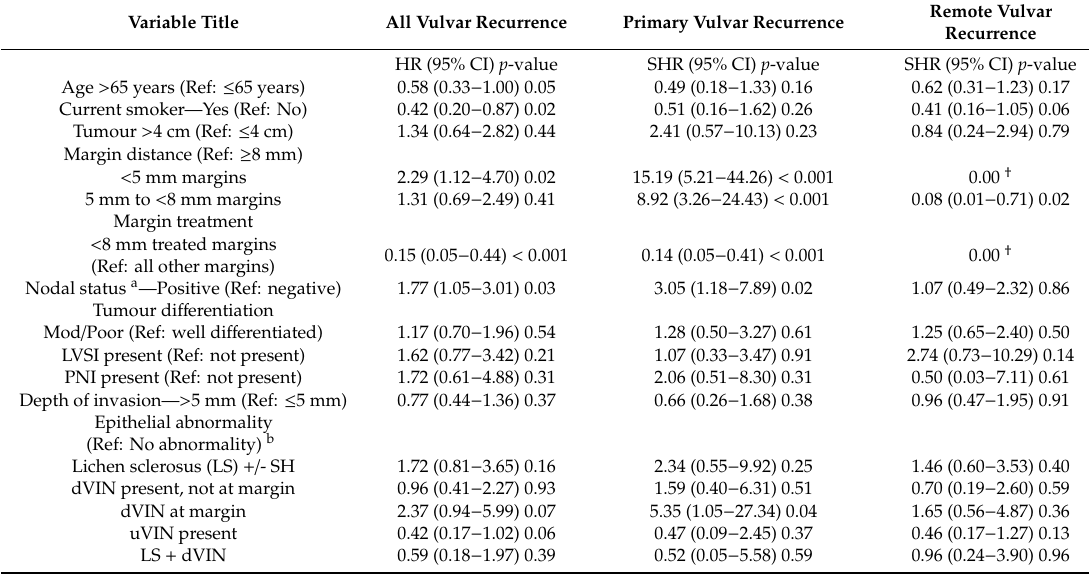
Table 3. Multivariable Cox and Fine–Gray regression analyses comparing all vulvar recurrences, and primary and remote vulvar recurrences to clinico-pathological